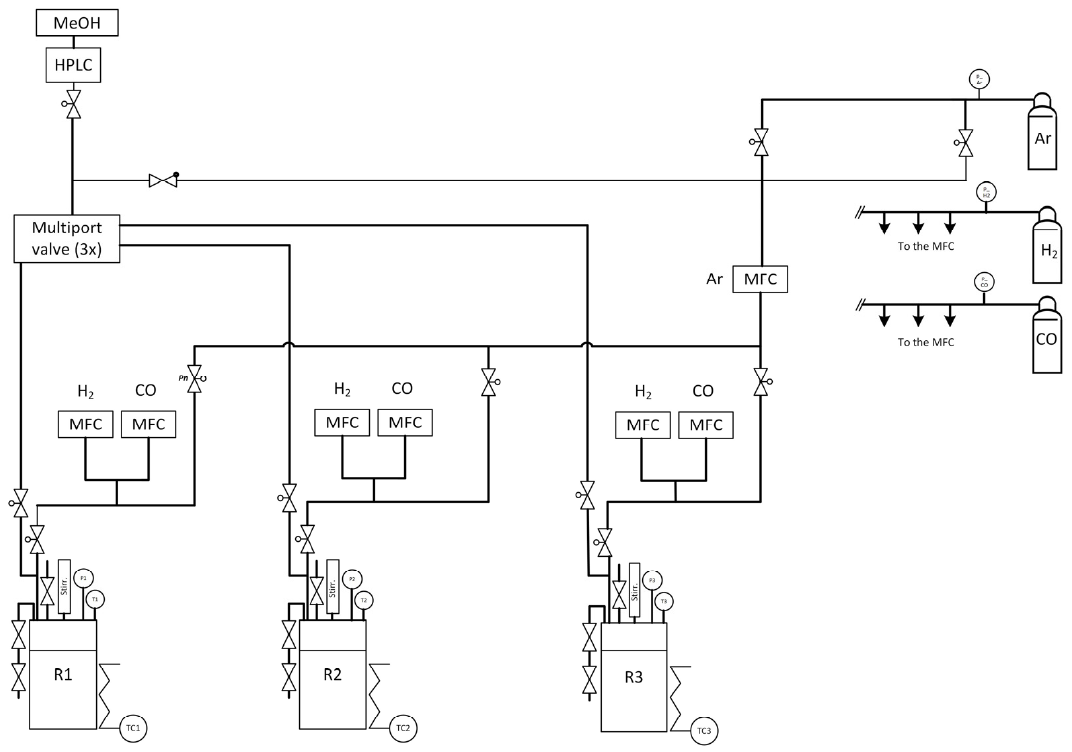
Figure 13. Flow chart of the PASCAR plant with all important devices.